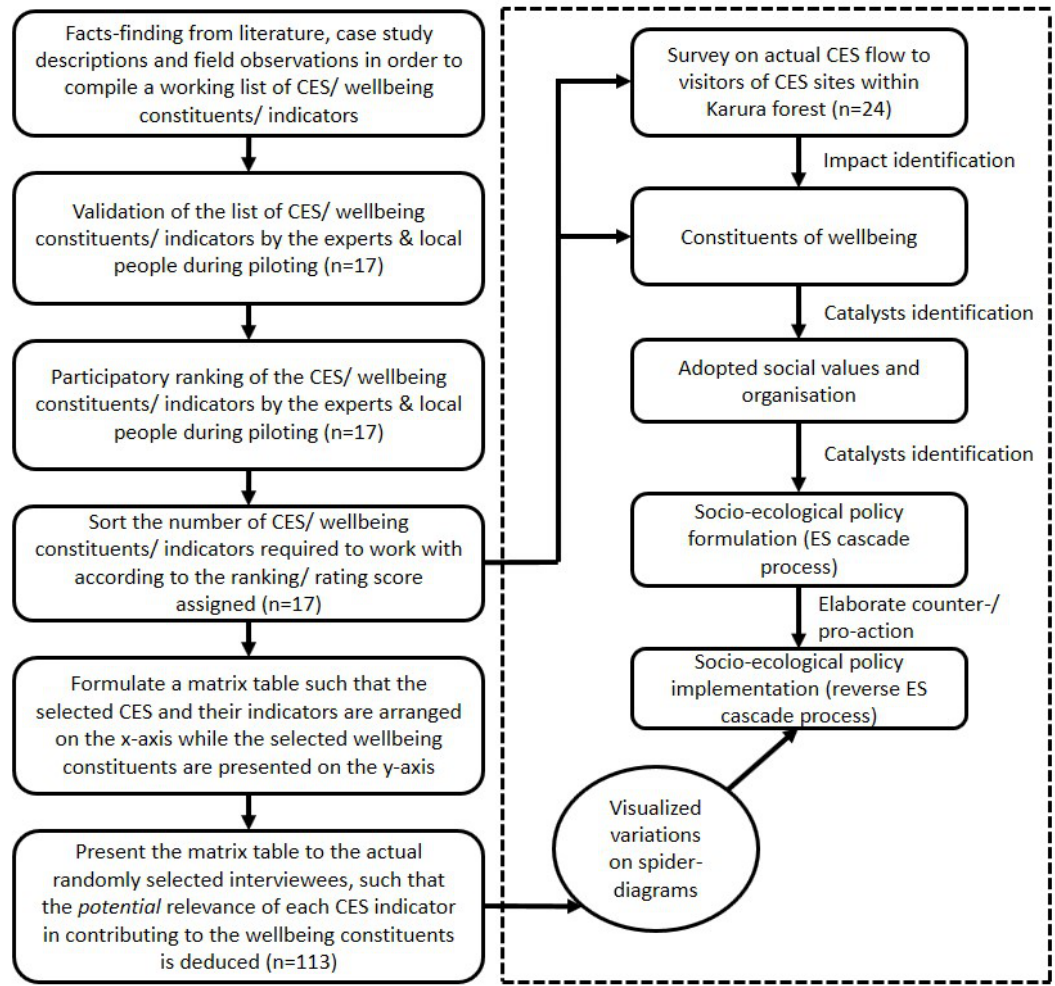
Figure 3: A summary of the methodology applied in the study. The dotted lines enclose the components that are integrated into the DPSIR model. n=17 represents respondents contacted for questionnaire pre-testing, n=24 and n=113 indicate the number of respondents in the respective survey exercises for the two fieldwork